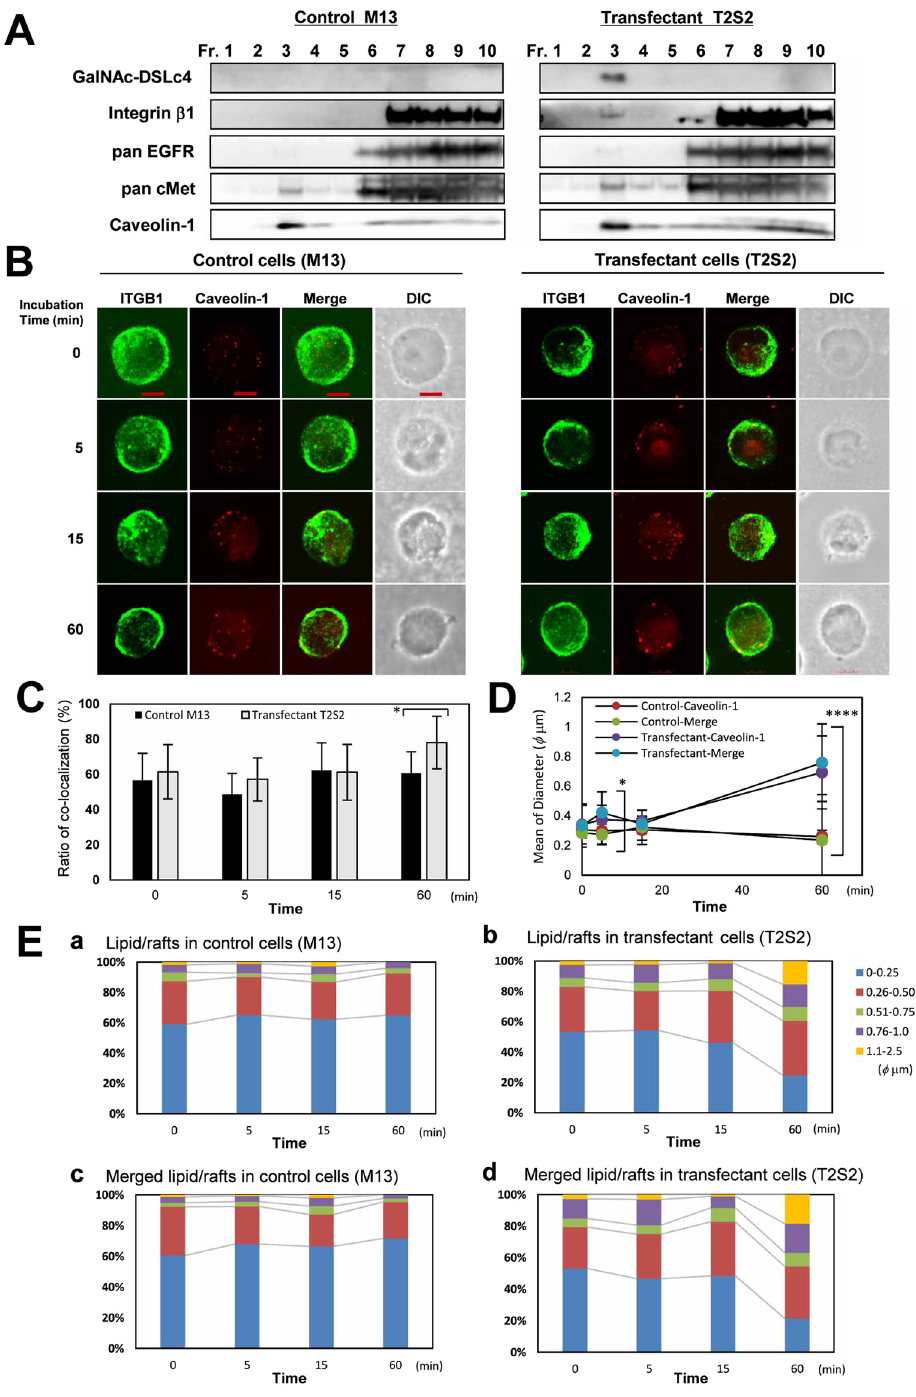
Figure 5. Intracellular localization of integrin β 1 and caveolin-1 during FCS stimulation. ( A ) Integrin β 1 was found in GEM/rafts during adhesion to LN-coated surface in the transfectants. Cells were lysed after incubation for 15 min at 37 °C, and separated by sucrose density gradient ultracentrifugation, and used for immunoblotting using anti-integrin β 1, anti-EGFR, anti-cMet, or anti-caveolin-1 antibodies. Fractions 1–4 contained low density fractions and fractions 6–10 corresponded to high density fractions. These were representative results among experiments repeated at least 3 times with similar results. All cropped blots were run under the same experimental condition. The full-length blots are presented in Supplemental Figure S7. ( B ) The clones were immunocytostained with anti-integrin β 1, anti-caveolin-1, and RM2 antibodies during FCS stimulation and adhesion onto LN. Cells were rotated under serum-free conditions for 30 min, and stimulated with 10% FCS. After incubation for 0, 5, 15, 60 min, cells were fixed in 4% paraformaldehyde for 10 min. Then, cells were stained for integrin β 1 (ITGB1, green ) and caveolin-1 ( red ), and their images were observed using a confocal microscope (Fluoview FV10i-DOC). DIC , image of differential interference contrast microscope. Scale